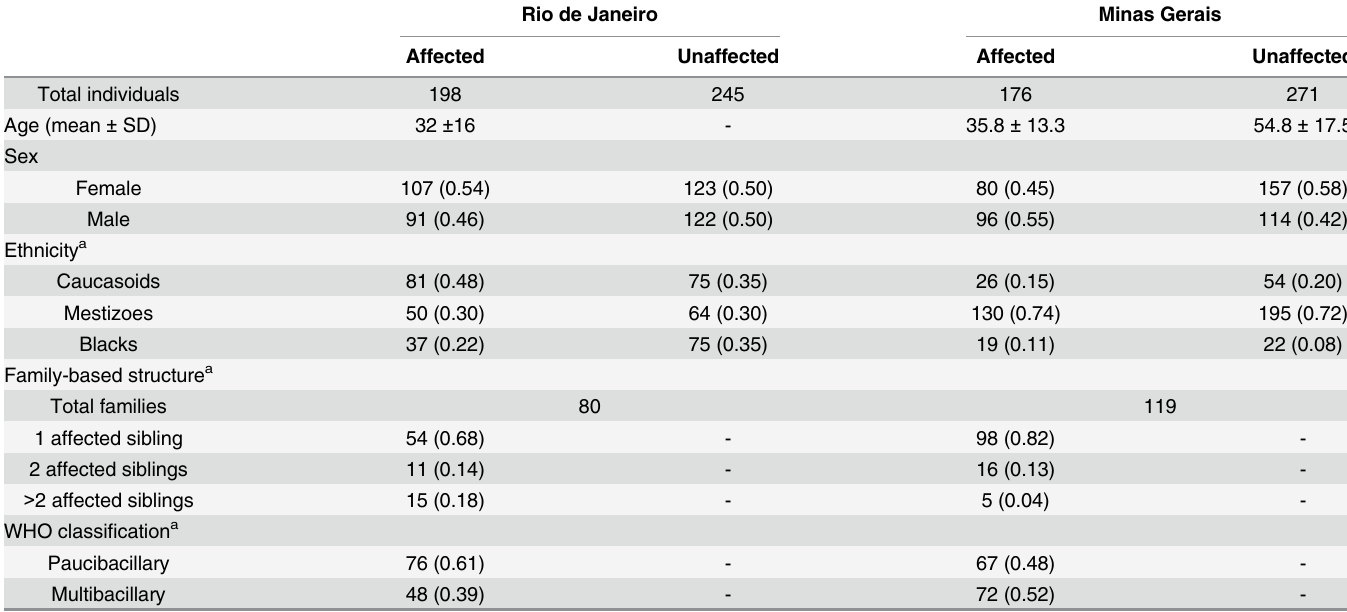
Table 1. Characteristics for the Brazilian family-based